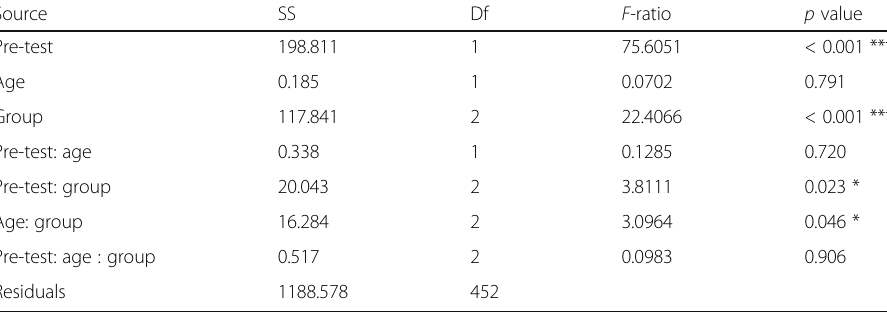
Table 5 Analysis of covariance (ANCOVA) type II SS result for Material 1 Source SS Df F- ratio p value Pre-test